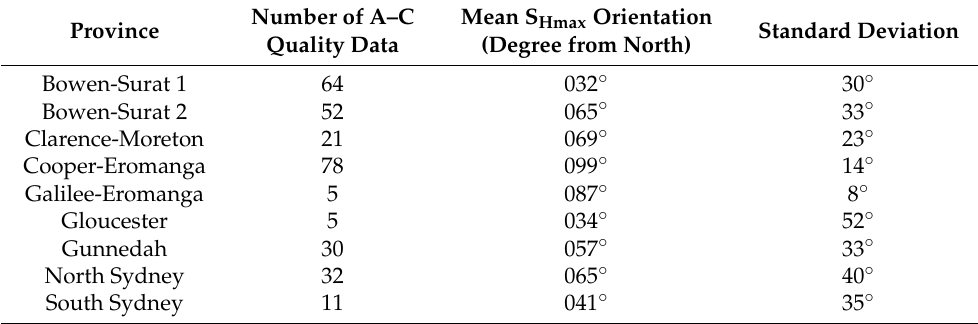
Table 4. Mean S Hmax orientation in different Australian CSG basins [14]. A–C refers to available stress data records in each basin based on the World Stress Map quality ranking criteria